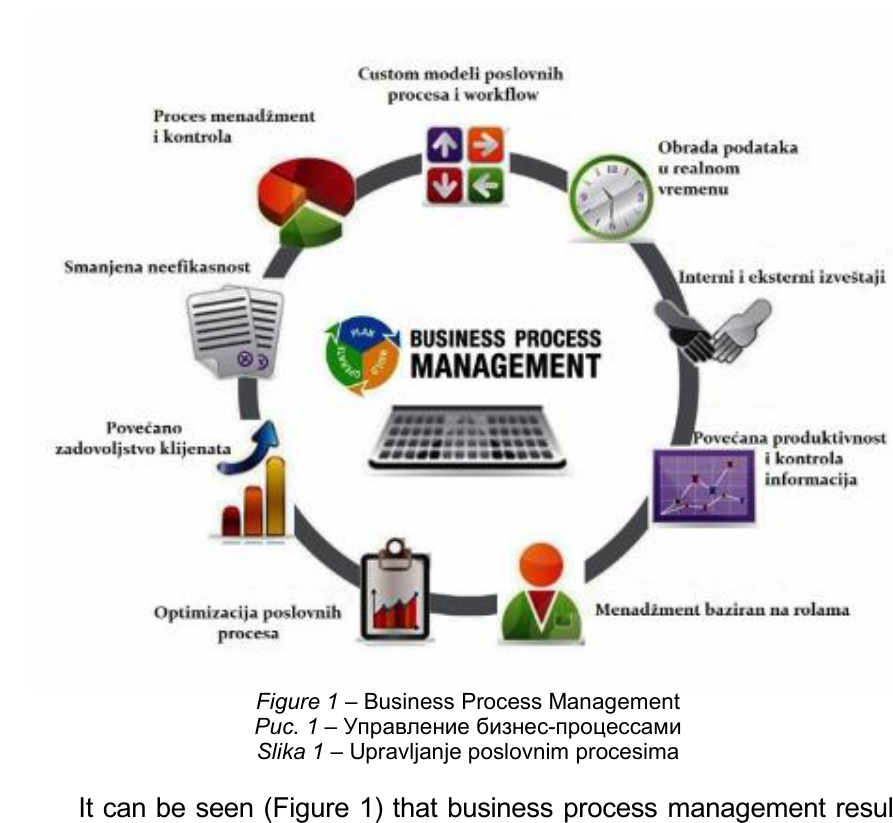
Figure 1 – Business Process Management Рис . 1 – Управление бизнес -